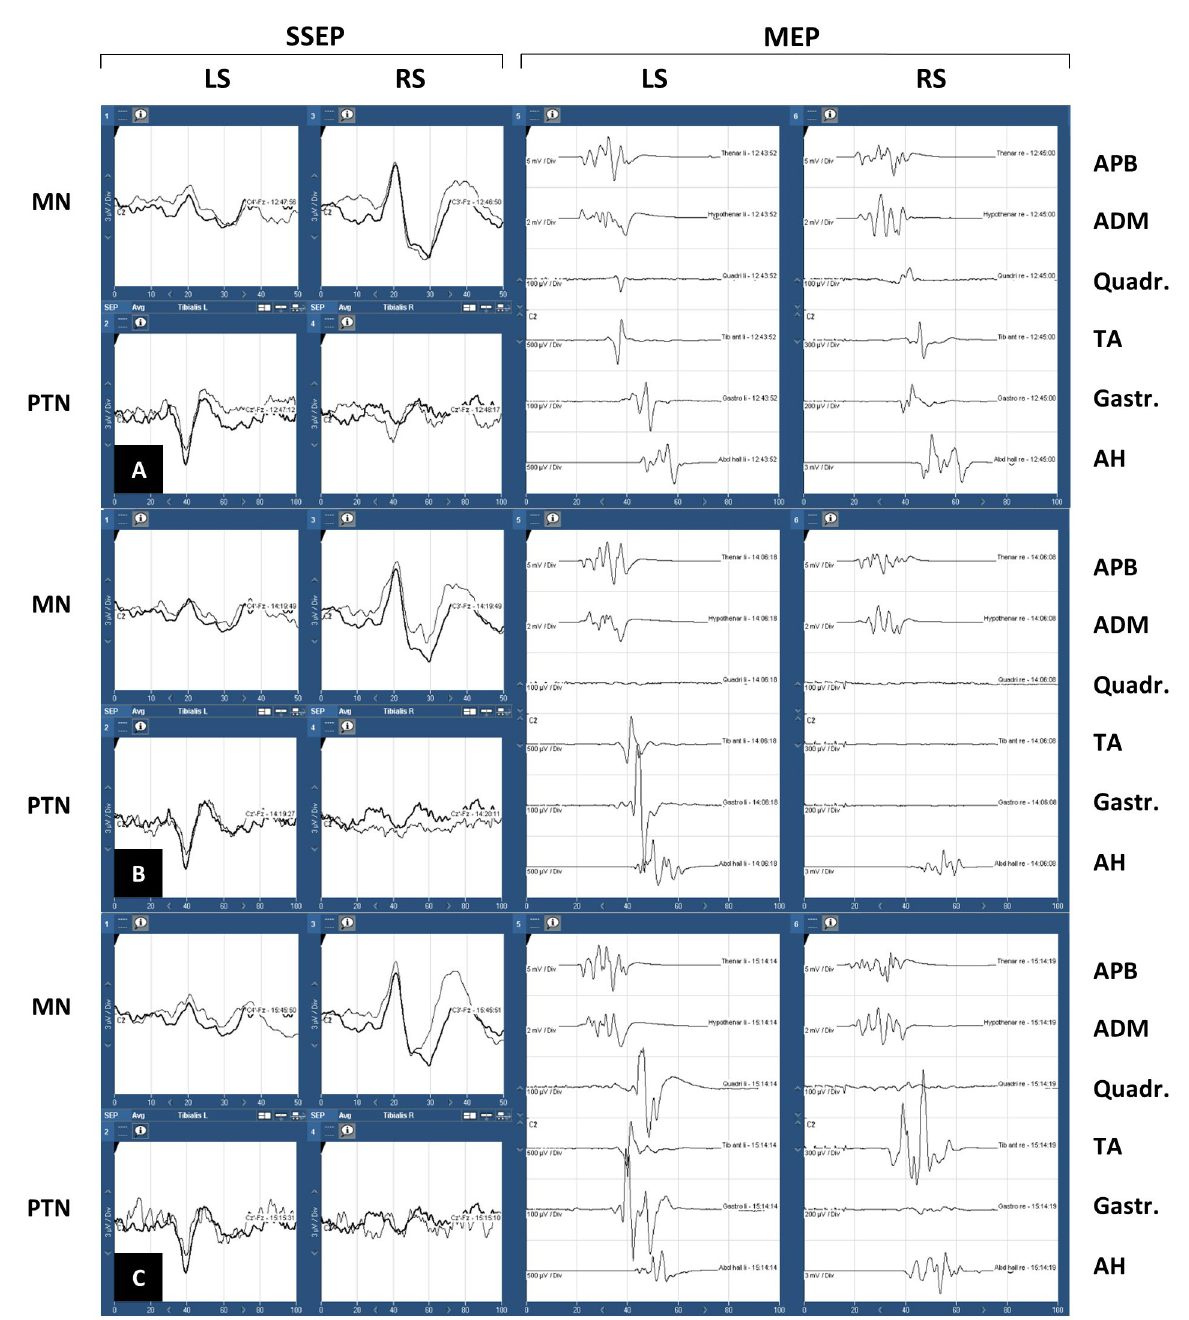
Figure 4. Descriptive case. ( A ) Baselines. ( B ) Loss of MEP of both Quadr and TA and Gastr in the right lower limb. Decrement of amplitude of PTN SSEP in the same limb. ( C ): Partial recovery of motor and sensory potentials. SSEP: somatosensory evoked potentials; MEP: motor evoked potentials; LS: left side; RS: right side; MN: median nerve; PTN: posterior tibial nerve; APB: abductor pollicis brevis muscle; ADM: abductor digiti minimi muscle; Quadr: quadriceps muscle; TA: tibialis anterioris muscle; Gastr: gastrocnemius muscle; AH: abductor hallucis